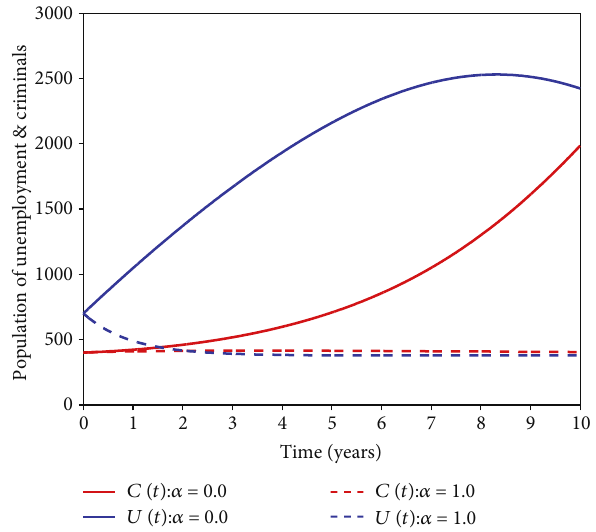
Figure 8: Simulation result showing the population of unemployment U ð t Þ and crime C ð t Þ